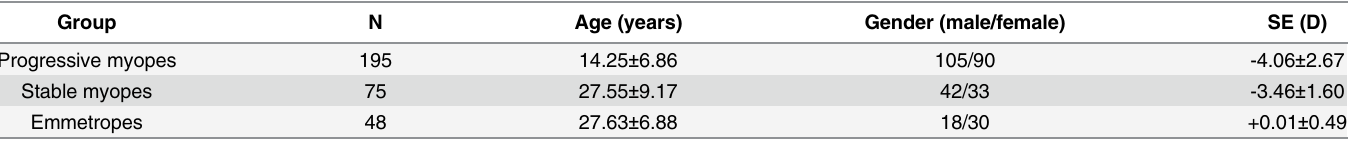
This table showed the demographic data of progressing myopes, stable myopes and emmetropes.